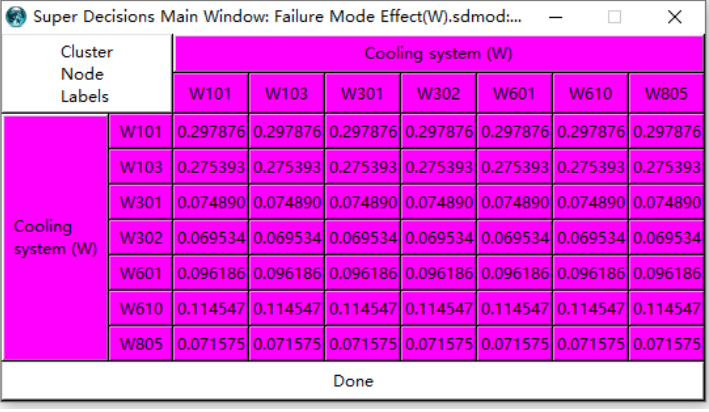
Figure 8. Super limit matrix of failure mode of machining center (W).